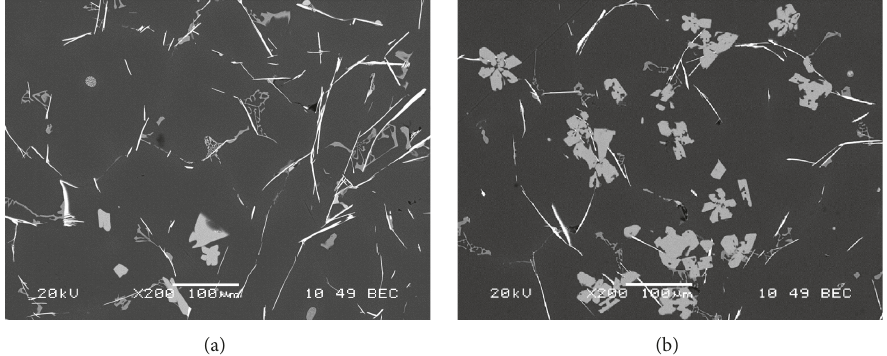
Figure 8: Backscattered electron images of base alloy + 1wt% La containing (a) 0.05 wt% Ti and (b) 0.15 wt% Ti.